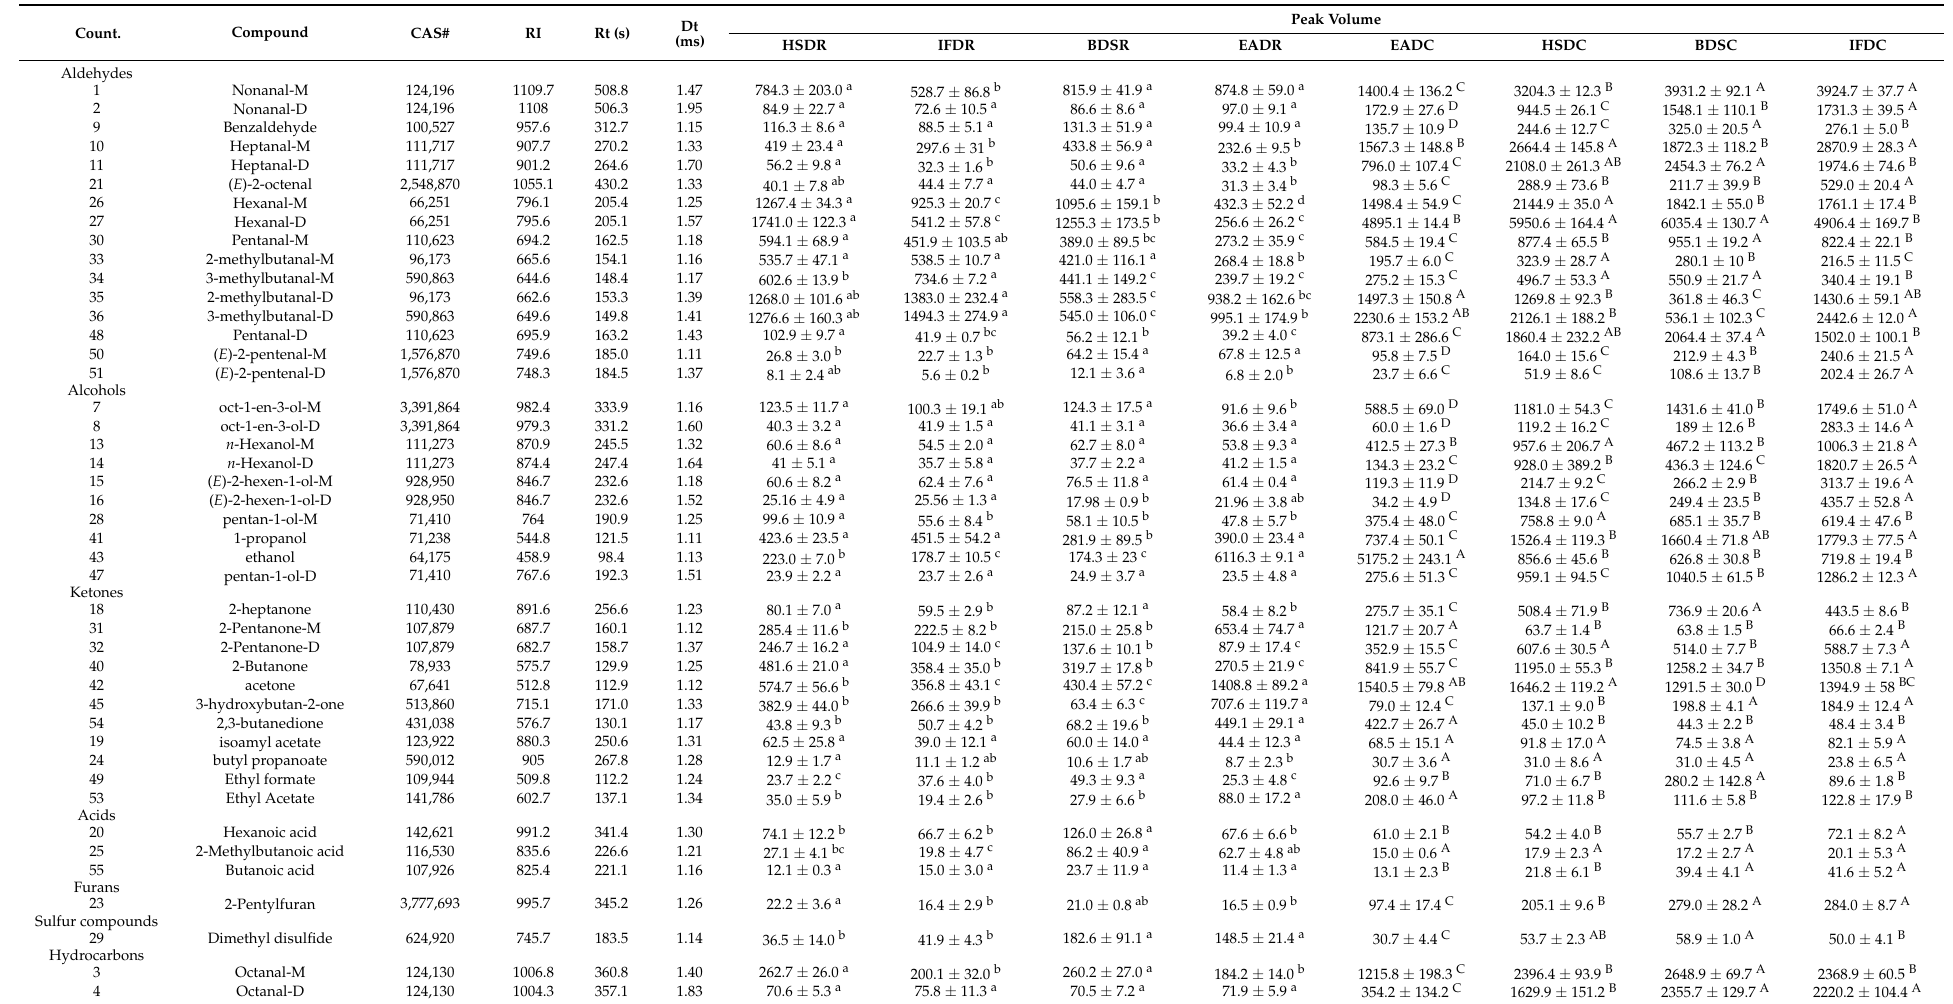
Table 2. Gas chromatography-ion mobility spectrometry (GC-IMS) integration parameters of volatile compounds in sea bass samples.